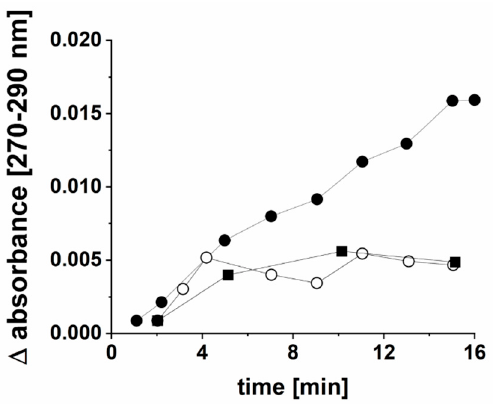
Figure 10. Cytochrome bd quinol oxidase activity of P. bivia . Oxidation of DMNH 2 in the presence of H 2 O 2 (peroxidase activity) was followed with solubilized membranes from P. bivia (closed circles) or P. bryantii (open circles). The control reaction was performed in the absence of solubilized membranes (closed squares).